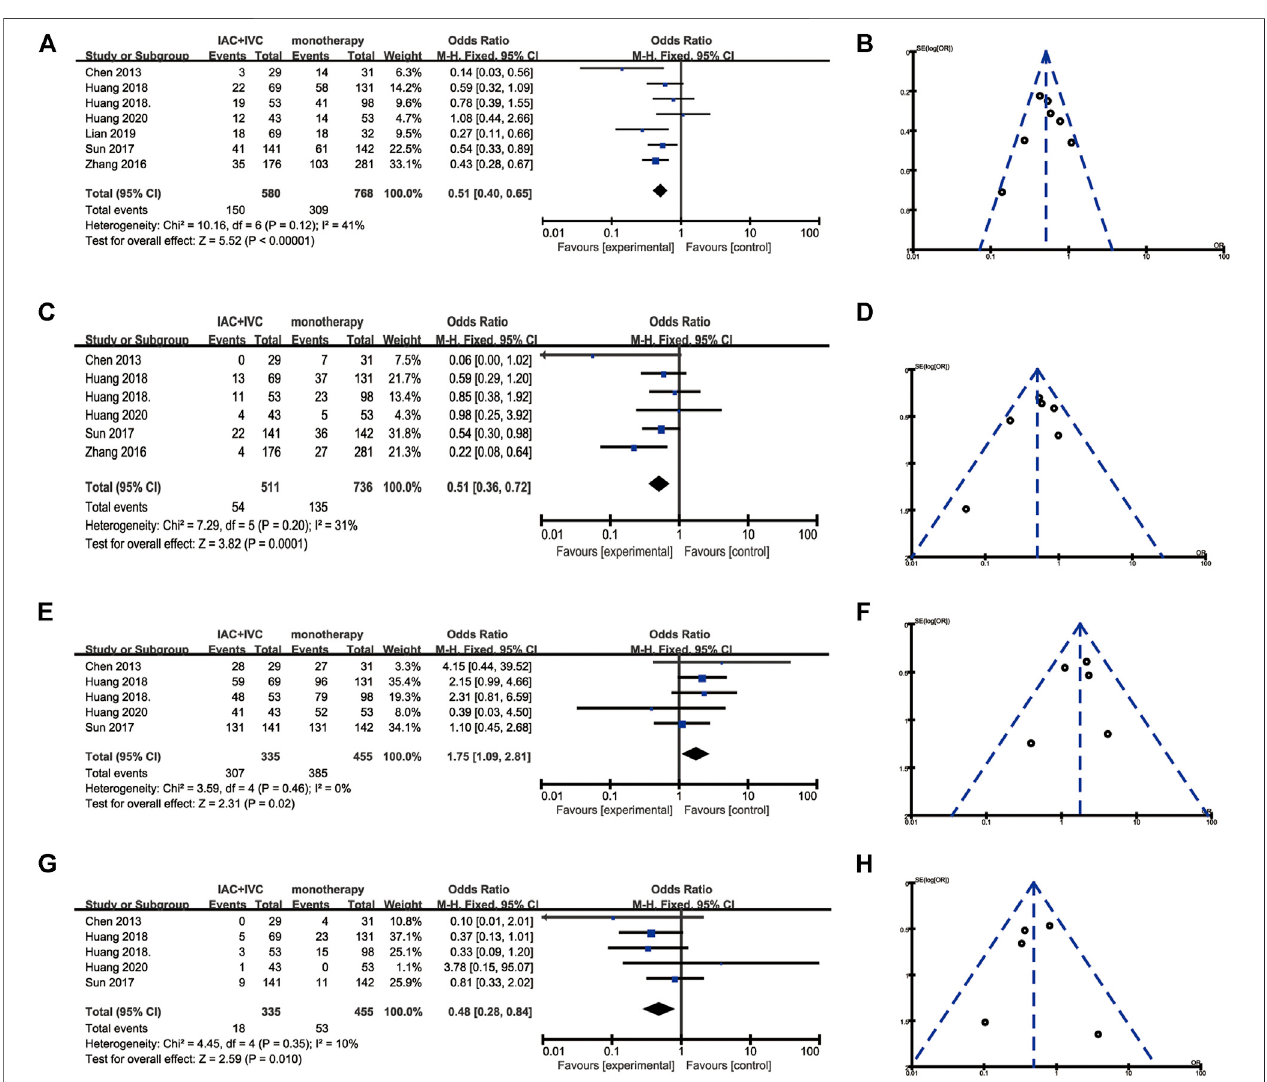
FIGURE 2 | Forest plots and funnel plots of IAC + IVC vs. intravesical installation. (A) Forest plot of tumor recurrence rate, (B) Funnel plot of tumor recurrence, (C) Forest plot of tumor progression rate, (D) Funnel plot of tumor recurrence, (E) Forest plot of survival rate, (F) Funnel plot of survival rate, (G) Forest plot of tumor-speci fi c death rate, (H) Funnel plot of tumor-speci fi c death